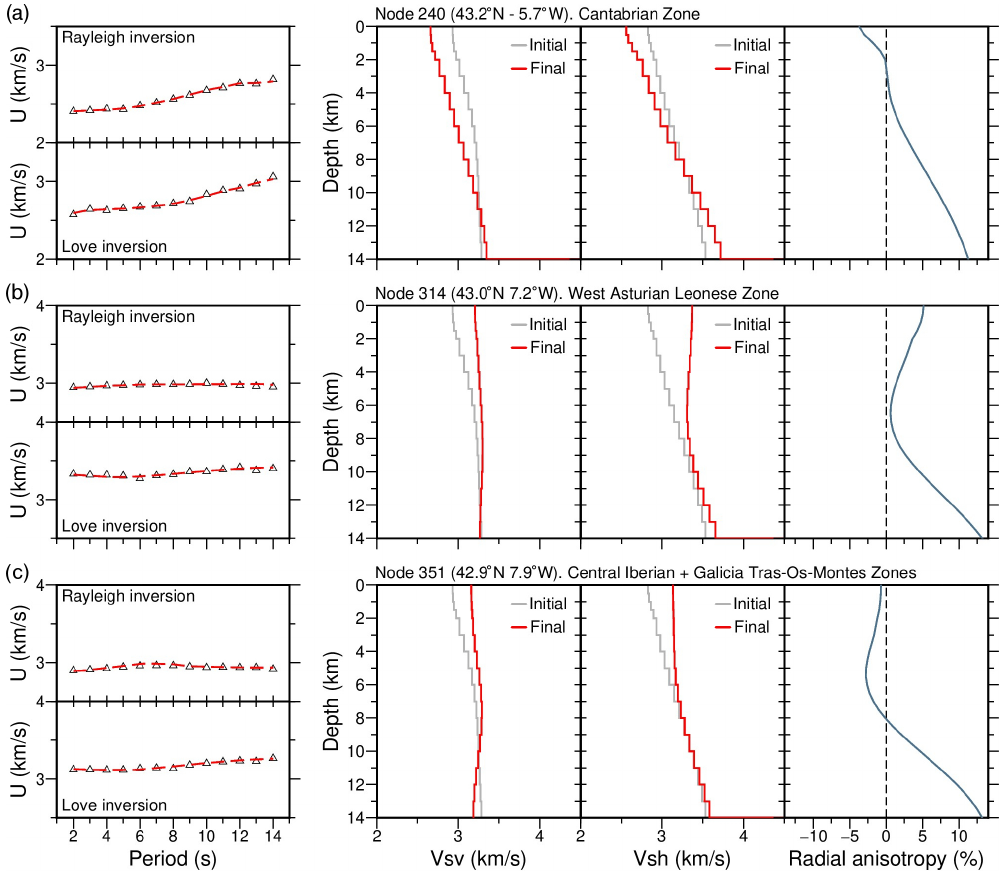
Figure 5. Depth inversion results in three nodes of the grid located in different geological domains of the Iberian Variscan orogen. Left panels display the observed group velocity data (triangles) and the inverted model fit to the dispersion (dashed red line). Central panels show the initial and final S-wave velocity models from Rayleigh (left) and Love (right) waves, respectively. Panels to the right depict the radial anisotropy magnitude calculated with Eq. (1). (a) Example of inversion result in the Cantabrian Zone. (b) Example of inversion result in the West Asturian–Leonese Zone. (c) Example of inversion result in the Central Iberian and Galicia Tras-Ós-Montes zones. U : group